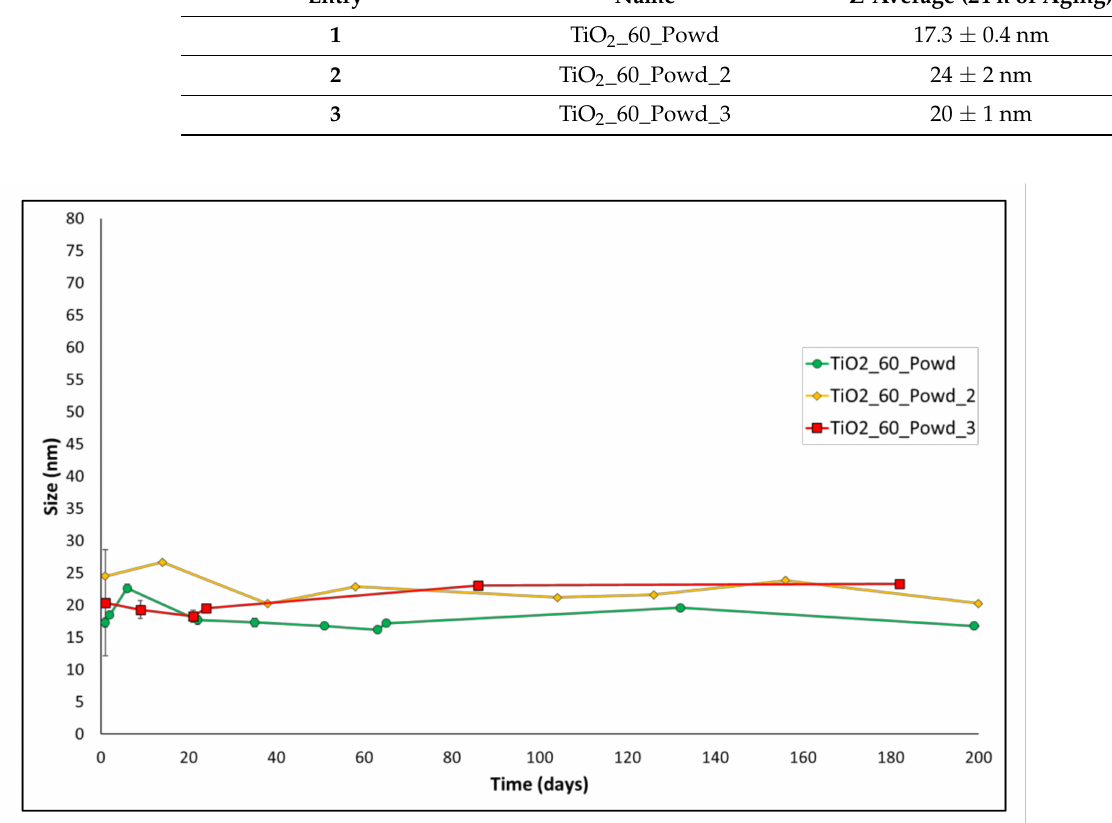
Figure 3. Aging of entries 1–3 of Table